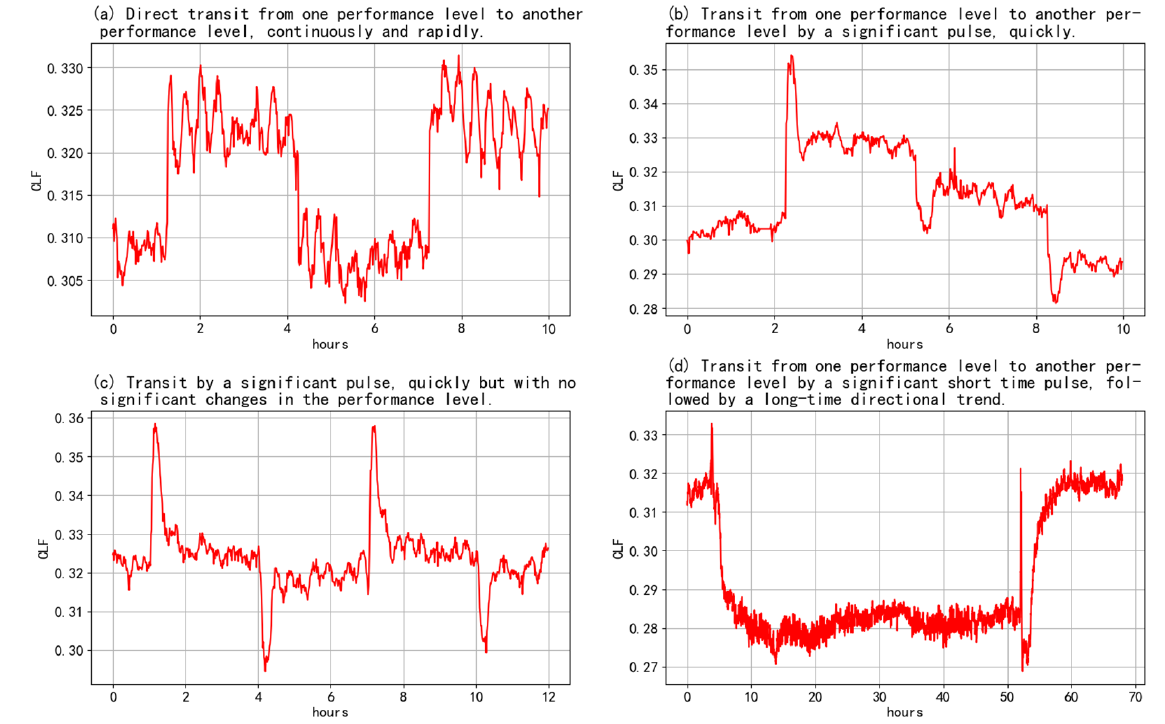
Figure 2. Illustration of transition processes, due to setpoint adjustment.